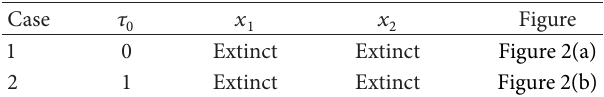
Table 3: Simulations of Model (4).